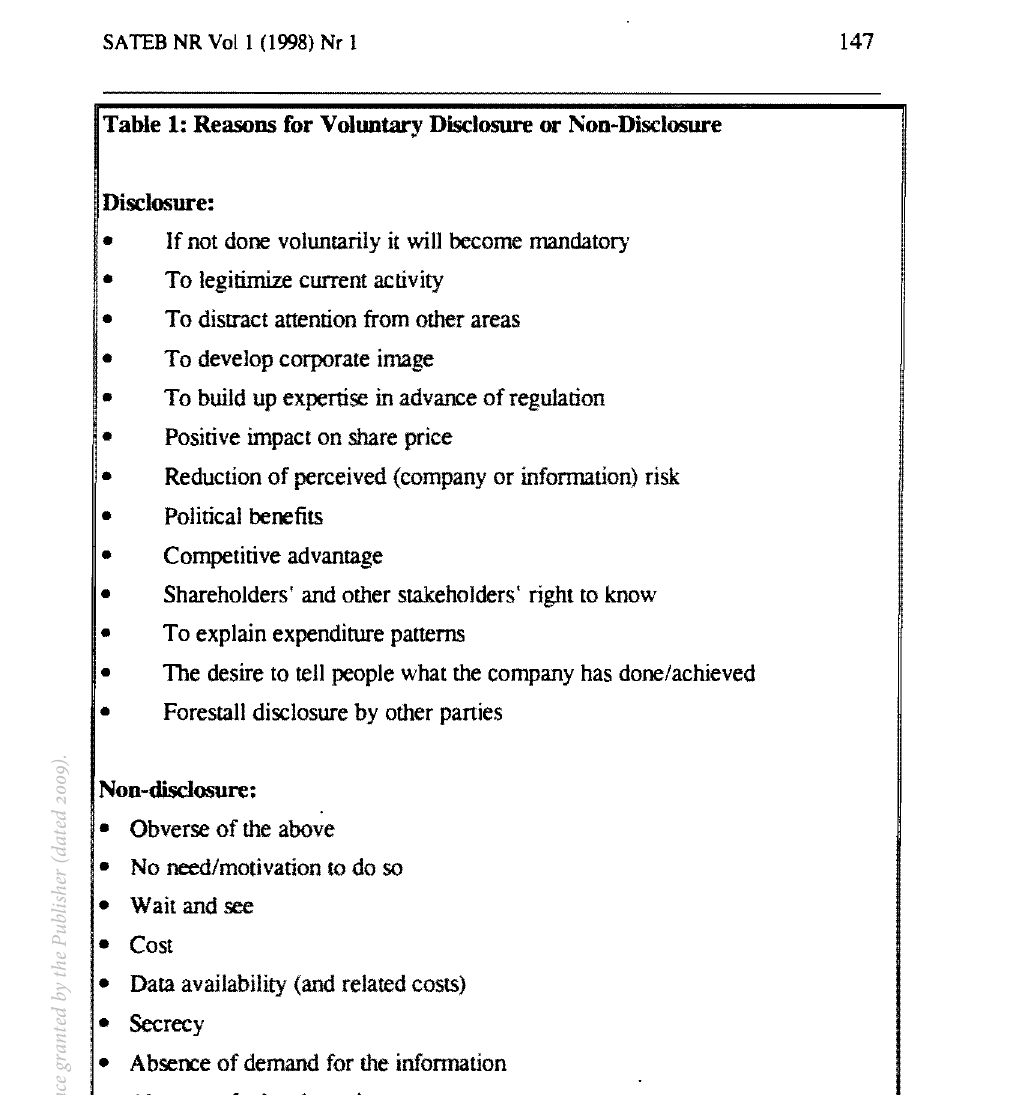
Table 1: Reasons for Voluntary Disclosure or Non·Disclosure